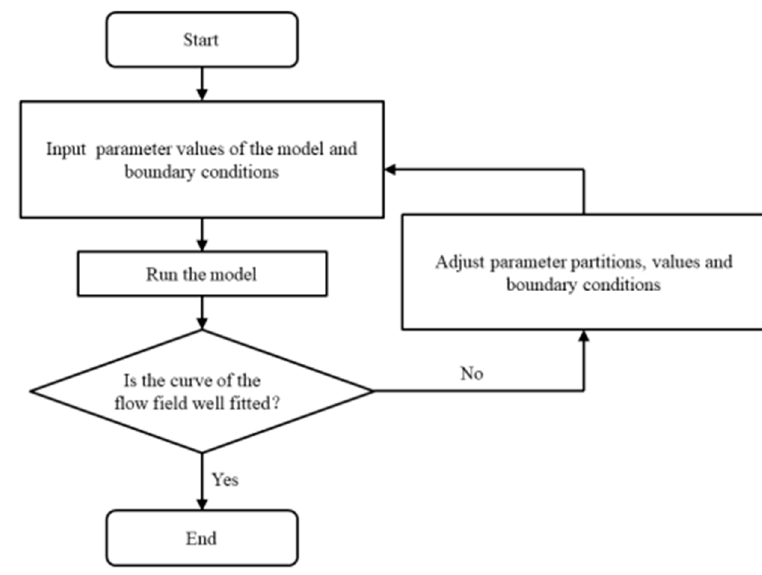
Figure 8. MODFLOW solving process.